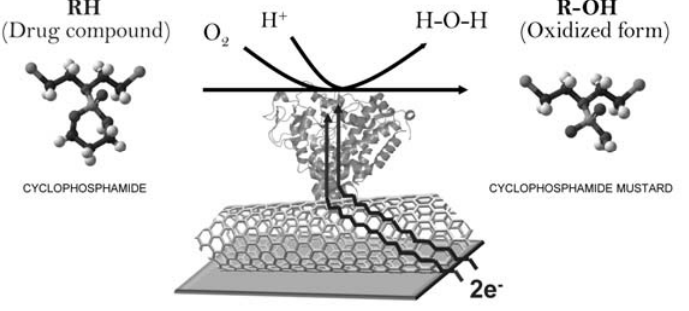
Figure 3. Schematic representation of the drug detection mechanism enhanced by carbon nanotubes. The example illustrates the reaction of hydroxylation for the anti-cancer drug cyclophosphamide.